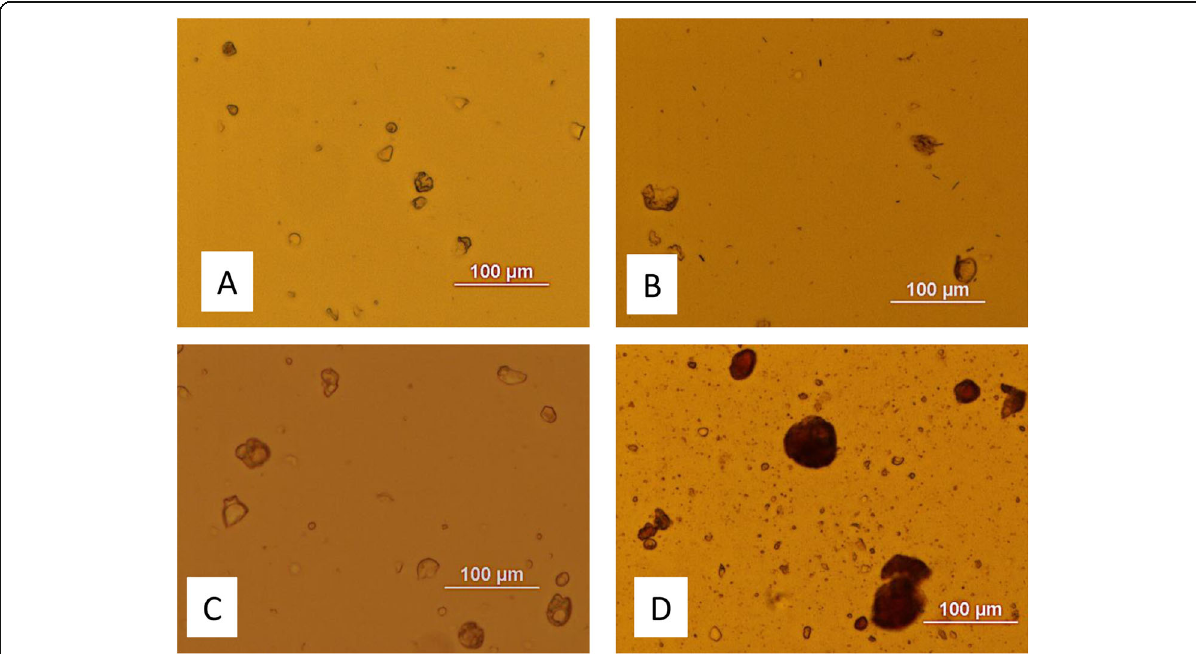
Fig. 6 Optical light microscope images at 200x magnification depicting the microstructures of diluted feed dispersions with 1:0 WPI:sucrose with 1% bioactives from pure gallotannin A , Aronia berry extract B , beet extract C , and cranberry extract D . *COLOR USAGE NECESSARY*